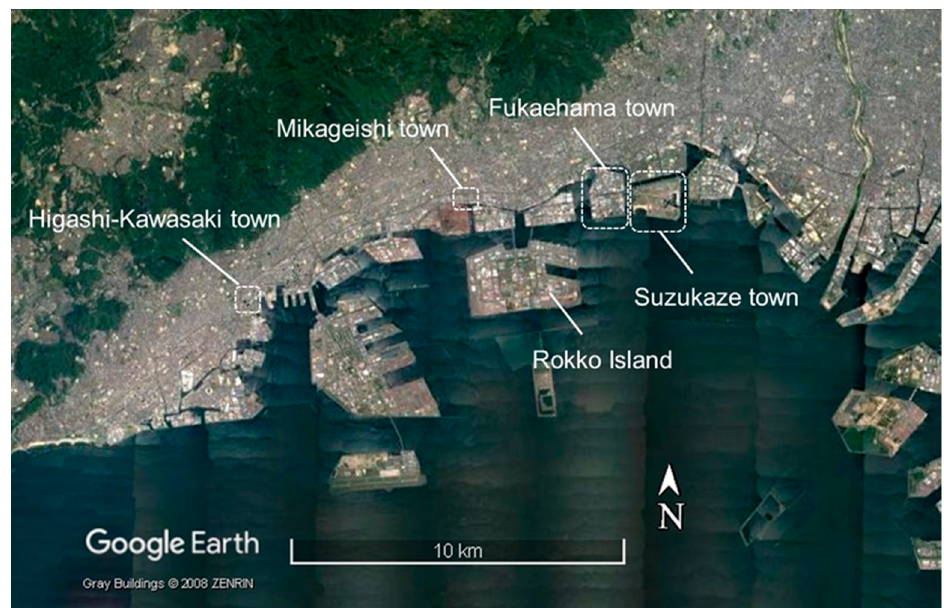
Figure 2. Map of survey locations. White boxes indicate areas visited. Rokko Island indicates the suspected initial location of the drifted containers.